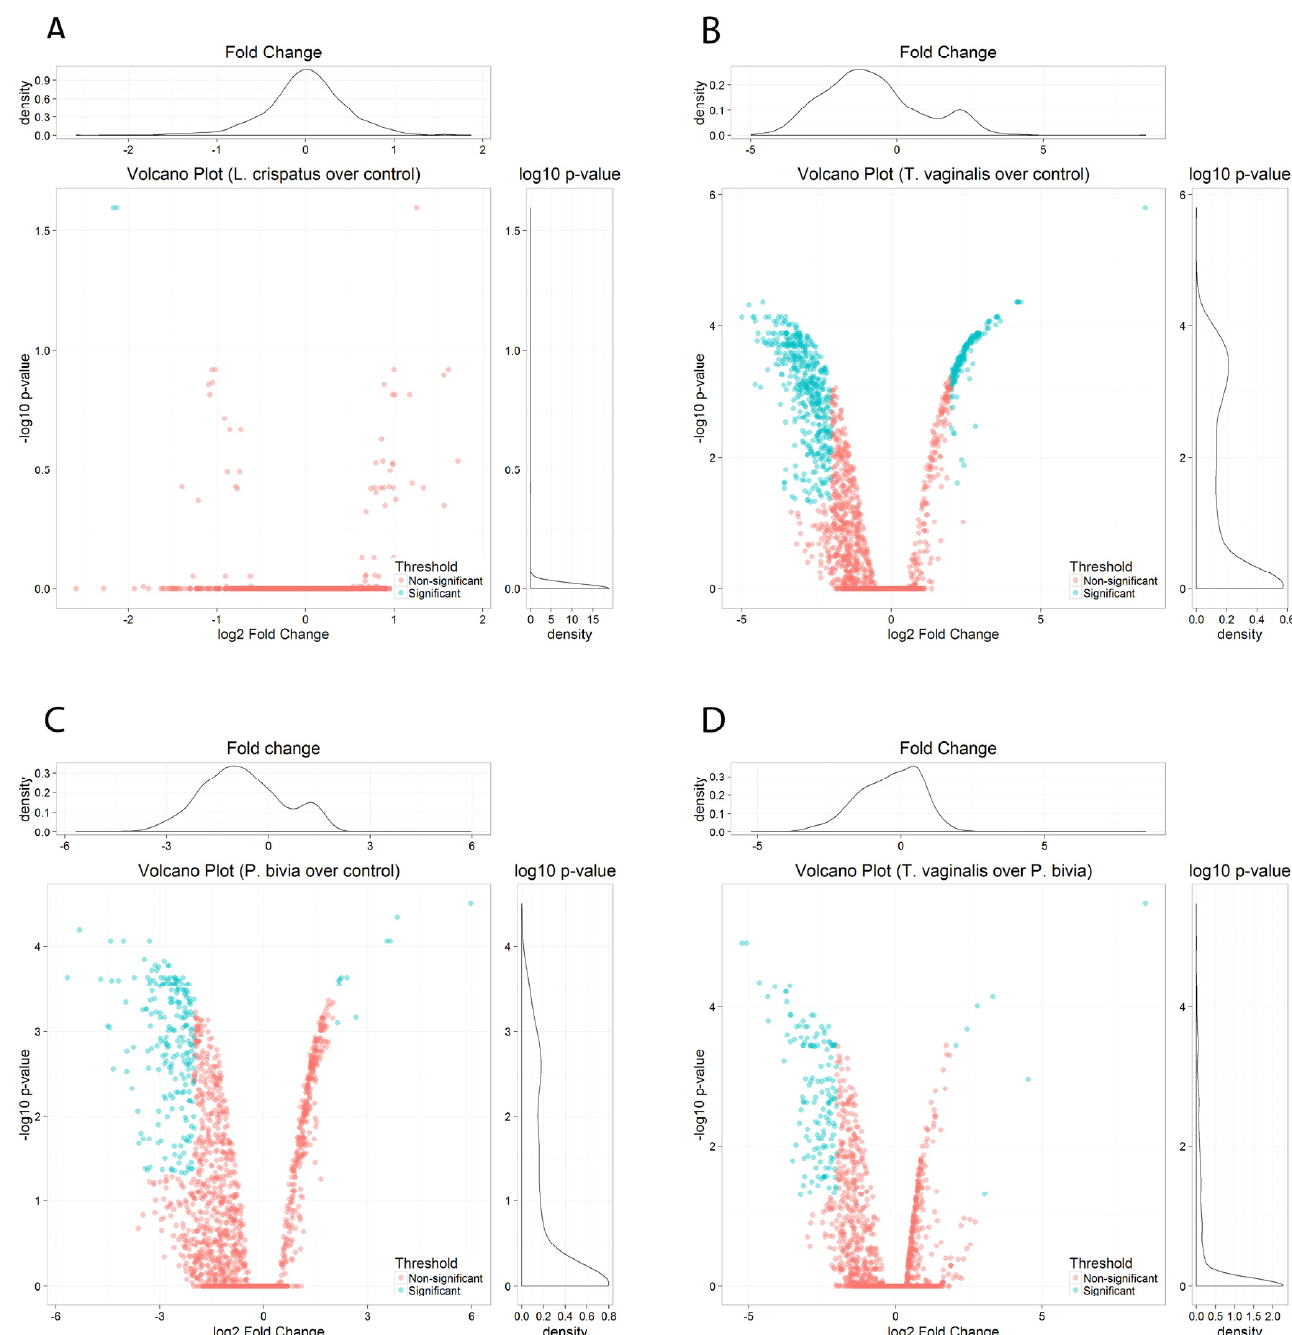
Figure 2. EV-miRNAs were differentially perturbed in response to vaginal challenge with T. vaginalis or BV-pathobiont while colonization by L. crispatus maintained a homeostatic equilibrium. Volcano plots show miRNAs differentially expressed by pairwise comparison of: ( A ) L. crispatus over control, ( B ) T. vaginalis over control, ( C ) P. bivia over control, and ( D ) T. vaginalis over P. bivia , depicting the log10 adjusted p value versus log2 fold change (FC) for each probe. Significance cut-off was set to adjusted p < 0.05 and log FC > 2: blue dots mark EV-miRNAs down- (to the left) and up- (to the right) regulated upon vaginal cell colonization. Pink dots mark non-significant